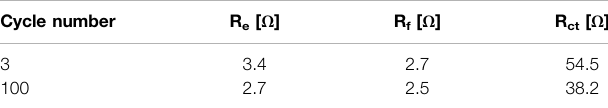
TABLE 3 | Fitting parameters of electrochemical impedance spectroscopy for SNF after 3 and 100